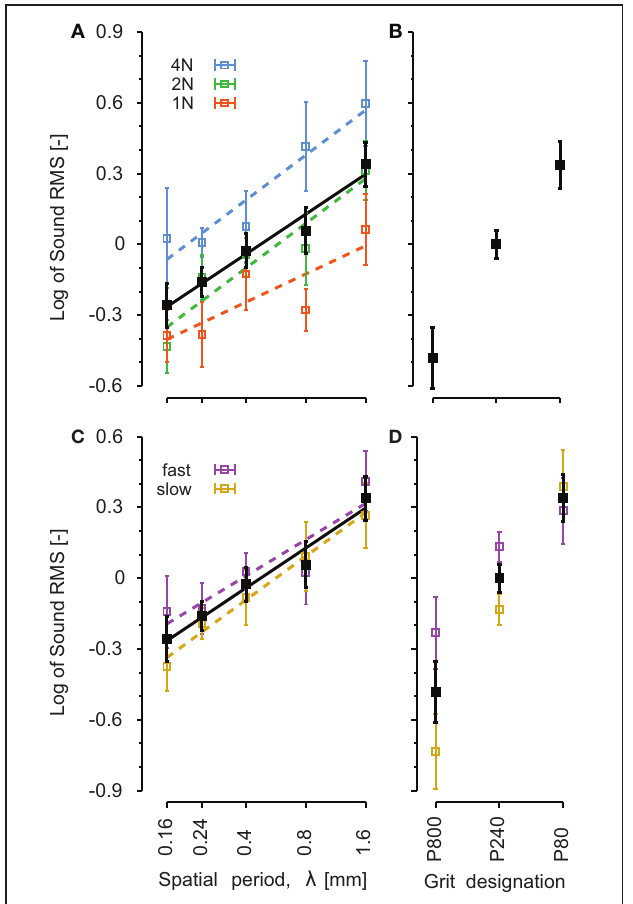
FIGURE 7 | Comparison of root mean square of the sound intensity on the different explored surfaces. Black traces correspond to all conditions pooled together and are identical for A,B and C,D . Colored traces correspond to different level of normal forces (A) and different finger velocities (C,D) . Periodic gratings (A–C) : λ is the spatial period of the periodic stimulus. The x-axis has a logarithmic scale. Sandpapers (B–D) : from smooth (P800) on the left to rough (P80) on the right. The lines represent linear regressions on means. Error bars indicate the standard error of the mean.